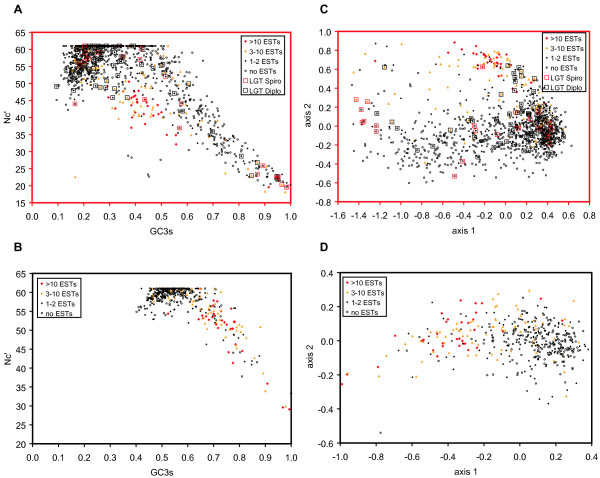
Comparisons of codon usage in S. salmonicida and G. lamblia. A and B: The effective number of codons, Nc', plotted against the synonymous G+C content in the third codon position (GC3s) of 1153 S. salmonicida genes (A) and 438 homologs in G. lamblia (B). Genes are represented by different colors and symbols according to the number of times they were sampled within the EST data. Genes identified to be involved in gene transfer and are shared with G. lamblia (LGT Diplo), or unique to S. salmonicida (LGT Spiro), are indicated by black and red squares, respectively (see Additional file 3). If the observed codon usage pattern is more uniform than expected by chance, the Nc' value is set to 61 [75, 117]. C and D: Correspondence analysis of the relative synonymous codon usage (RSCU) values for the same genes as in A and B for S. salmonicida (C) and G. lamblia (D). The candidate LGTs unique to S. salmonicida, and shared with G. lamblia, are indicated by red and black open squares, respectively.